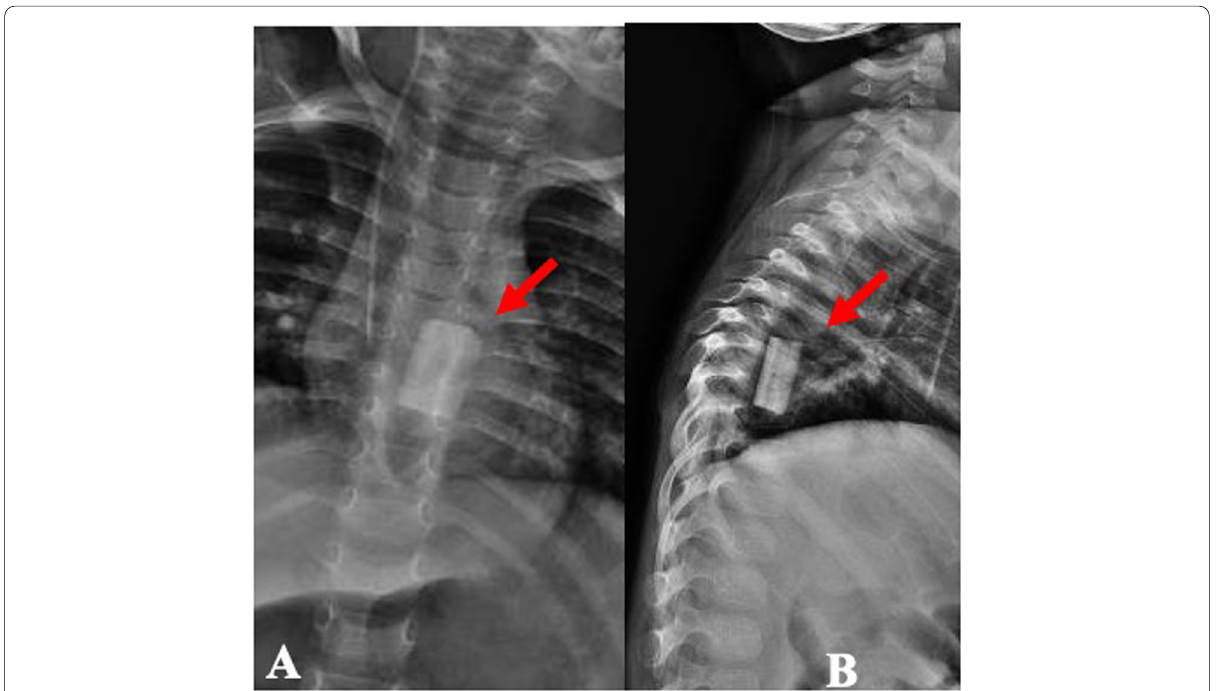
Fig. 5 A Ap view and B lateral view of a dorsal spine radiograph post‑surgery with fibula allograft (red arrow) between vertebrae D6 and